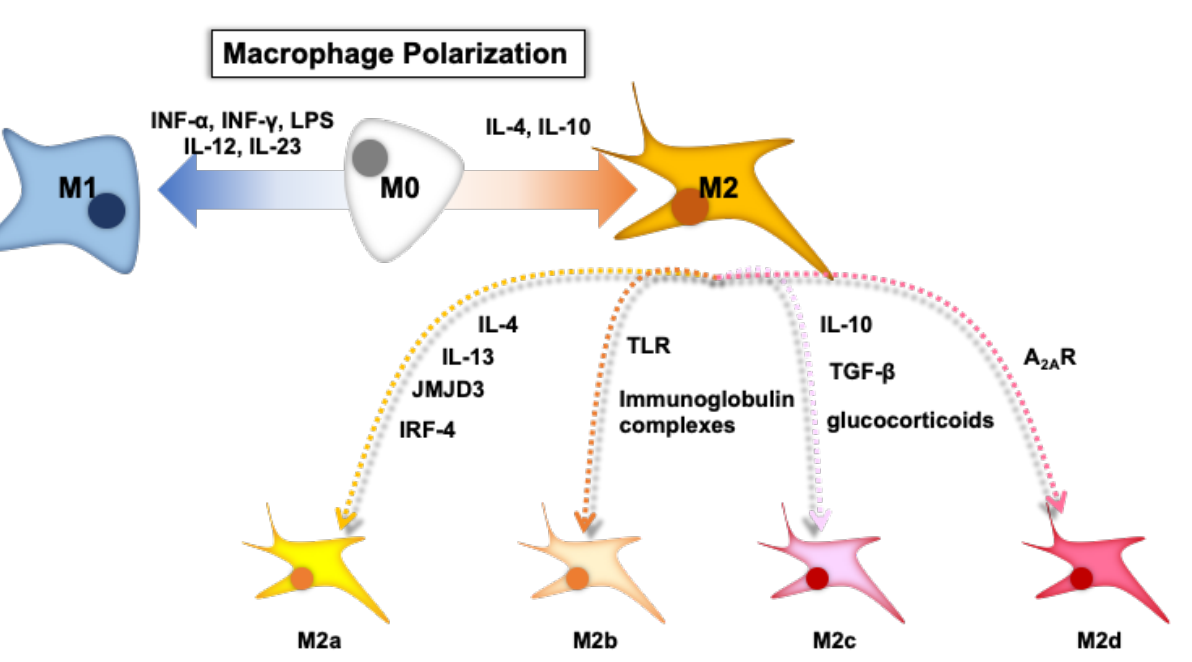
Figure 1. The depicted scheme of macrophage polarization. Note: Figure 1 was adapted and modified from a previous paper with permission from Elsevier [9].